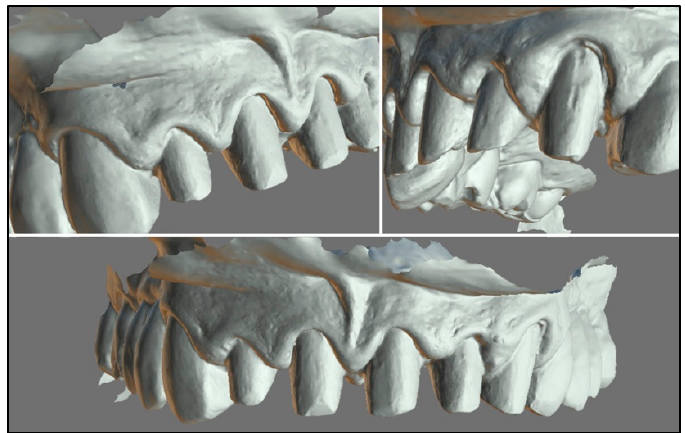
Figure 9. Intraoral scanning post-healing. Optimal definition can be observed at the marginal level of each preparation.